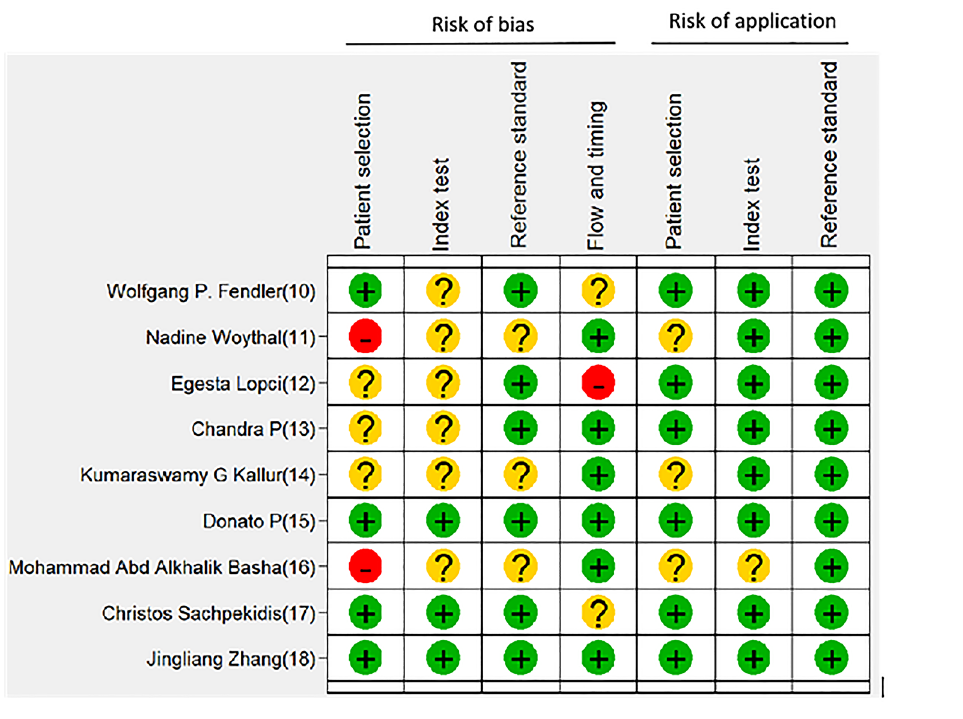
Figure 2 - Risk of bias and applicability concern summary: Review the authors' judgments of each of the areas covered in the study by QUADAS-2 (Quality Assessment of Diagnostic Accuracy Studies-2